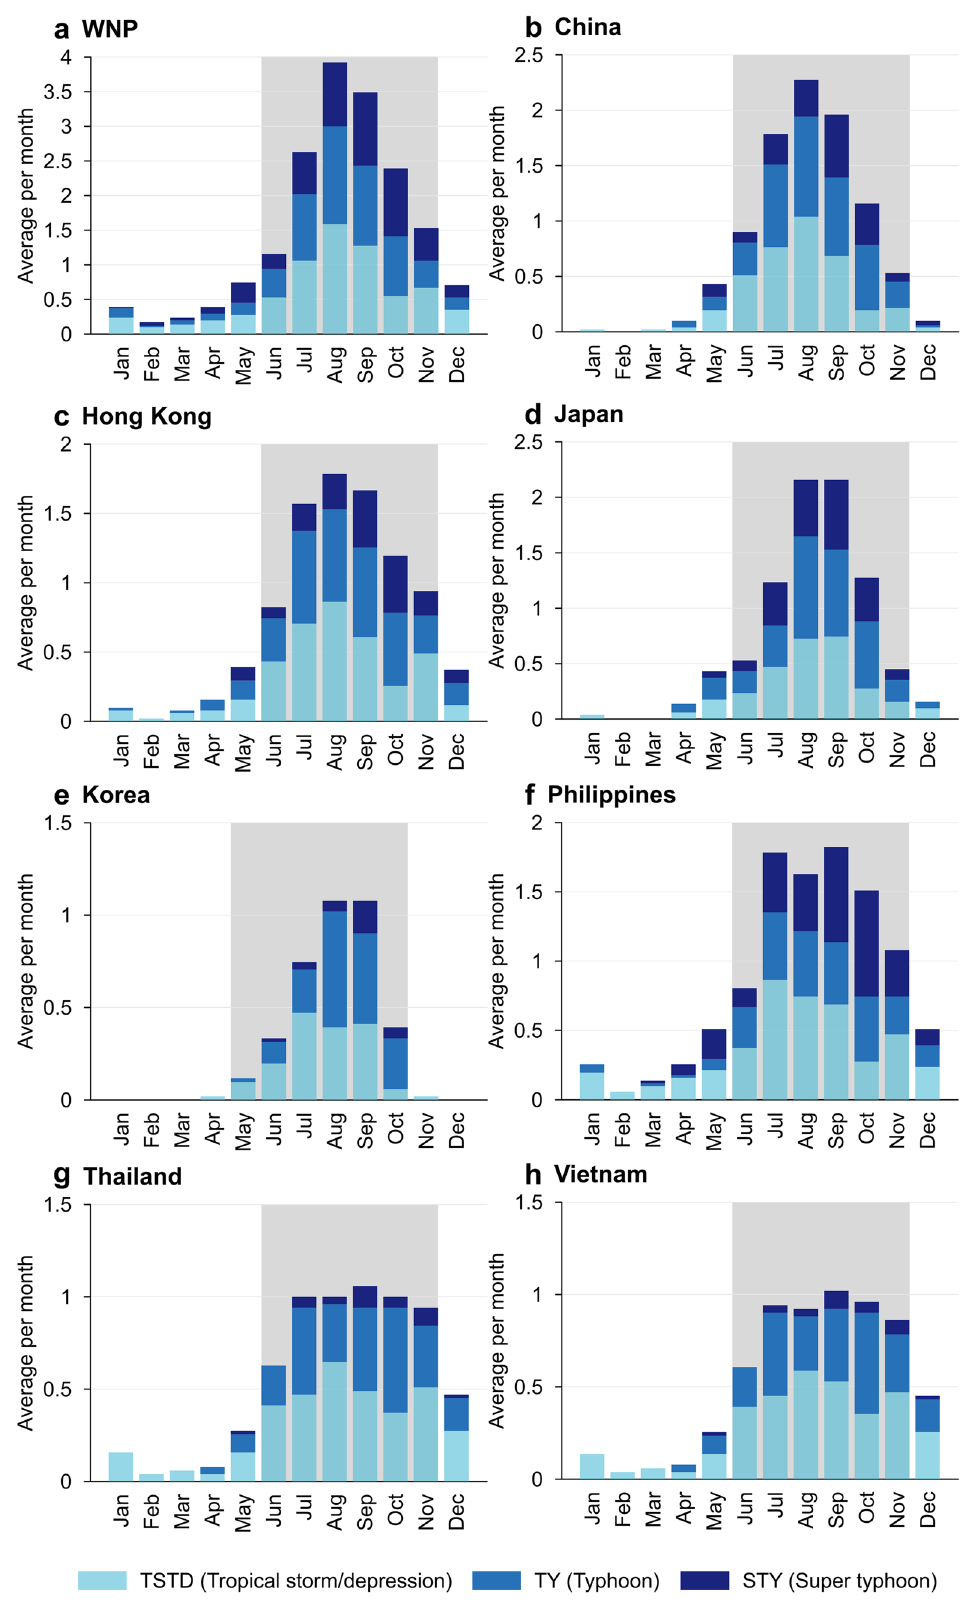
Figure 2. Monthly climatology (average per month) of western North Pacific (WNP) tropical storm/ depressions (TSTD), typhoons (TY), and super typhoons (STY) between 1987 and 2020. Grey shaded area indicates most active 6-month period for each location and defines the 6-month typhoon season modelled in this